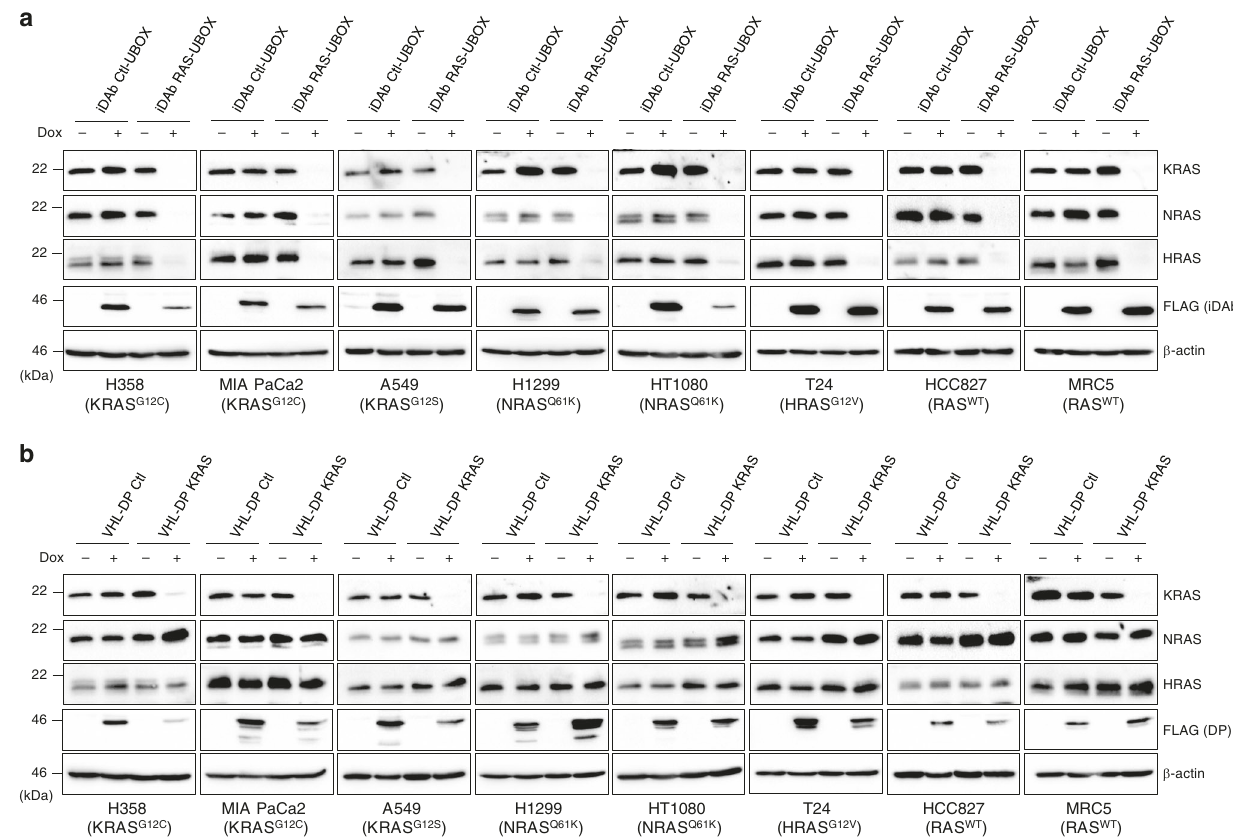
Fig. 3 Ef fi cacy of pan-RAS and KRAS degraders in cancer cells. Western blot of RAS family protein levels following induction of the macrodrug degraders. a , b Ef fi cacy of the pan-RAS ( a ) and KRAS degraders ( b ) to deplete their target(s) in various human cell lines with the indicated variety of RAS mutations. KRAS, NRAS and HRAS protein levels were judged by Western blots after 72 h of doxycycline treatment of the cells at 0.2 μ g.mL − 1 ( + ) or not induced ( − ). The lines used were mutant KRAS cell lines H358, MIA PaCa2 and A549, mutant NRAS H1299, HT1080 and mutant HRAS T24 cell lines and RAS WT HCC827 and MRC5 cells. Expression of the degraders is shown with the FLAG antibody. β -actin is the loading control. Each experiment in a , b was performed twice. a , b Source data are provided as a Source Data fi